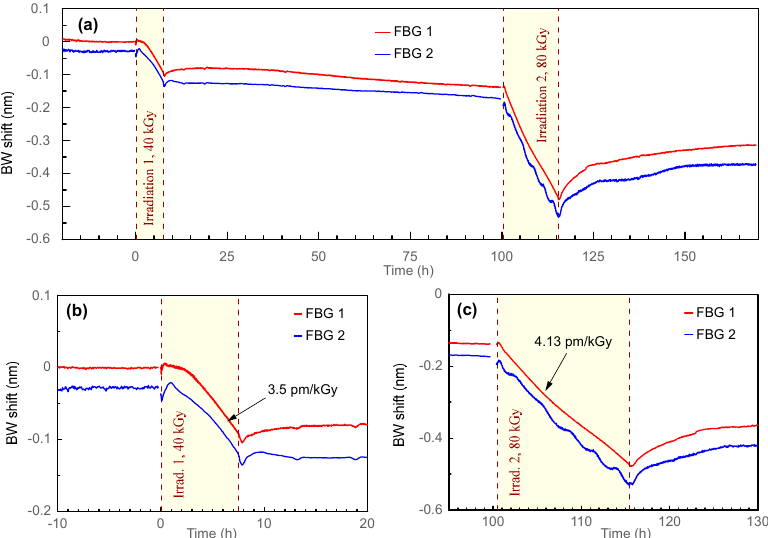
Figure 4. The Bragg wavelength evolution during the first and the second irradiation sessions: ( a ) general view; ( b ) irradiation 1 (40 kGy); ( c ) irradiation 2 (80 kGy). We introduced an additional BW shift of − 30 pm for the FBG 2 for more convenient analysis of the